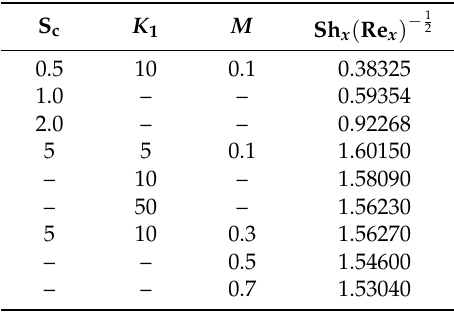
Table 3. Numerical value of Sherwood number Sh x ( Re x ) − value of Pr = 10, R d = 0.1, ϕ = 0.1, Bi = 0.1, θ w = 0.5, λ 1 = 0.5 f (cid:48) ( ζ )